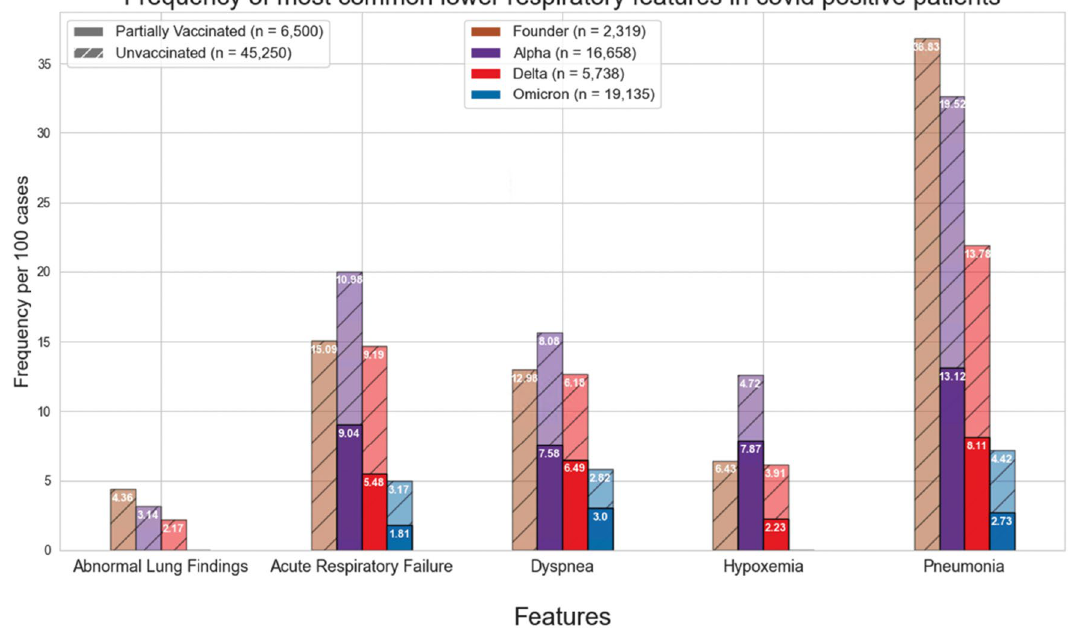
Figure 6. Comparison of frequency of most common lower respiratory features in COVID positive patients based on partially vaccinated or unvaccinated status.